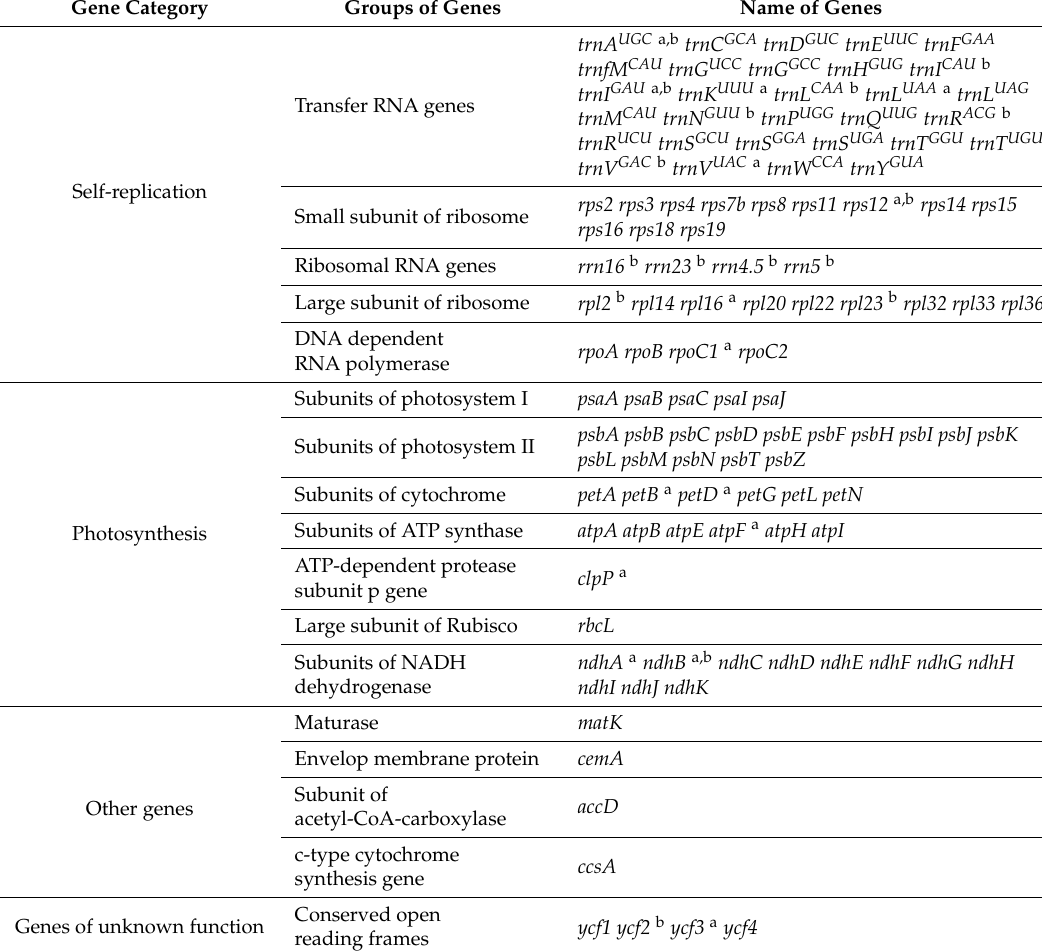
Table 3. List of genes in the C. edulis plastid